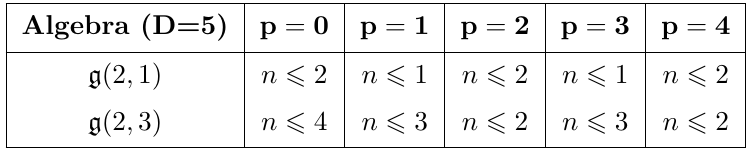
Table 3 . Invariance conditions for the expanded terms